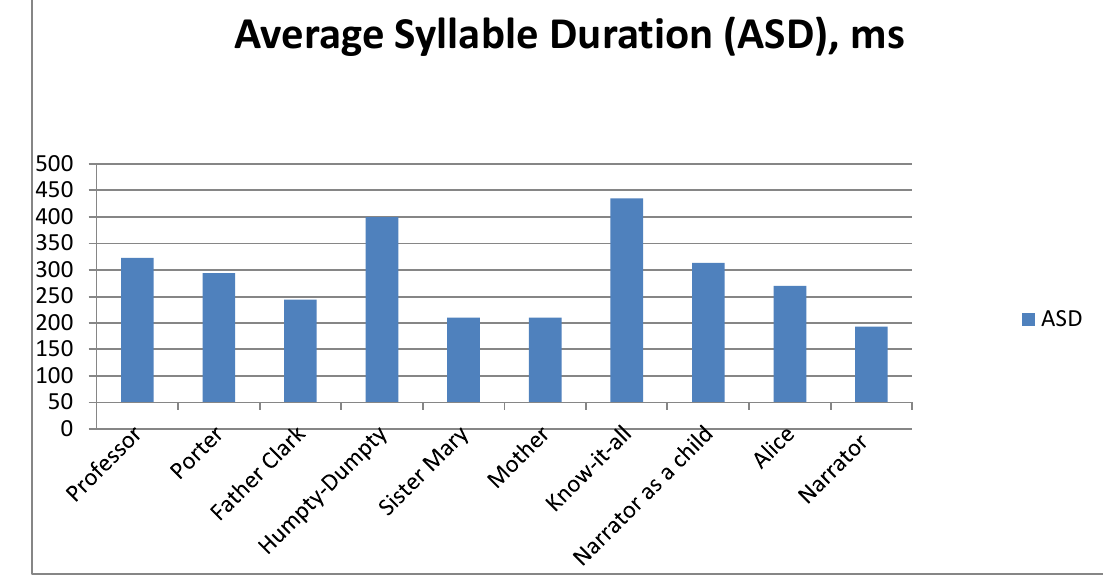
Fig. 2 Average Syllable Duration (ASD) across the ten characters’